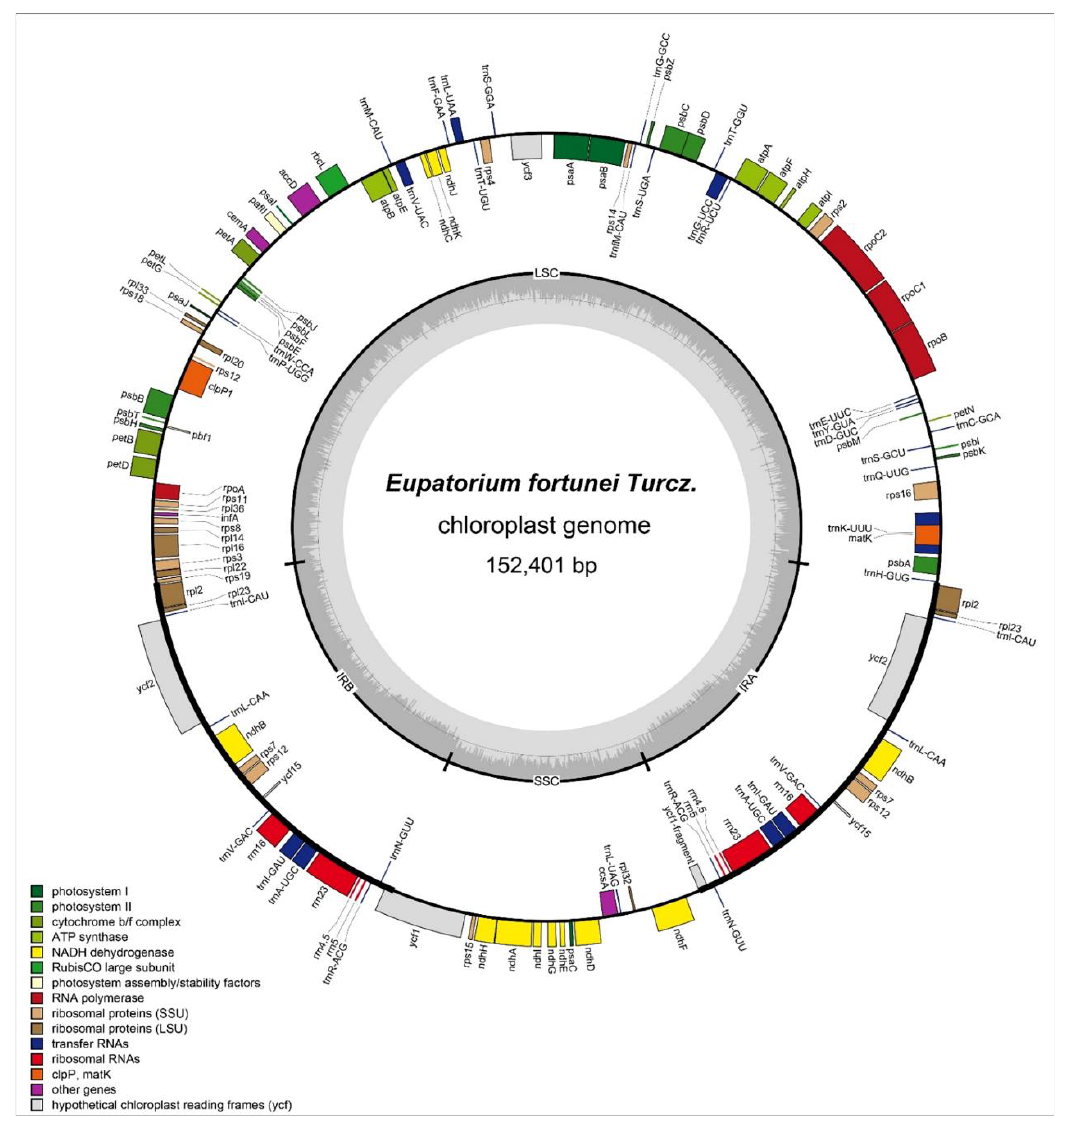
Figure 1. The chloroplast genome of E. fortunei. Genes located outside the outer rim are transcribed in a counterclockwise direction whereas genes inside the outer rim are transcribed in a clockwise direction. The colored bars indicate the known different functional groups. The dashed gray area in the inner circle shows the percentage GC contents of the corresponding genes. LSC, SSC, and IR denote large single copy, small single copy, and inverted repeat, respectively. Table 1. The basic characteristics of the chloroplast genomes of three Eupatorieae